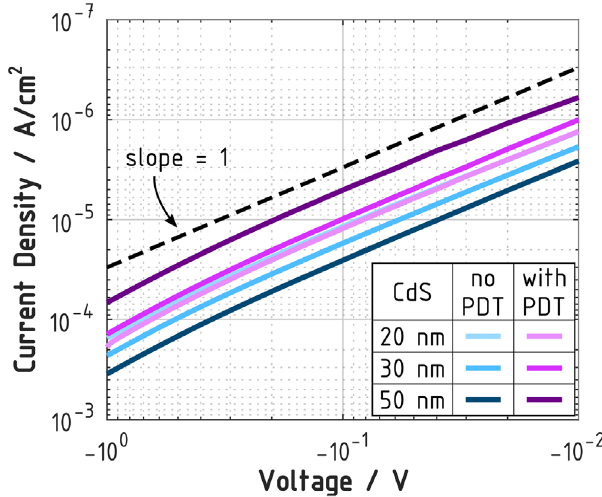
Fig. 5. Determining the nature of shunt leakage currents: Double-logarithmic representation of dark IV data averaged across 7 – 9 samples per cell type in the range from − 1 V to 0 V. For comparison, the dashed black line indicates an ohmic behaviour with a slope of